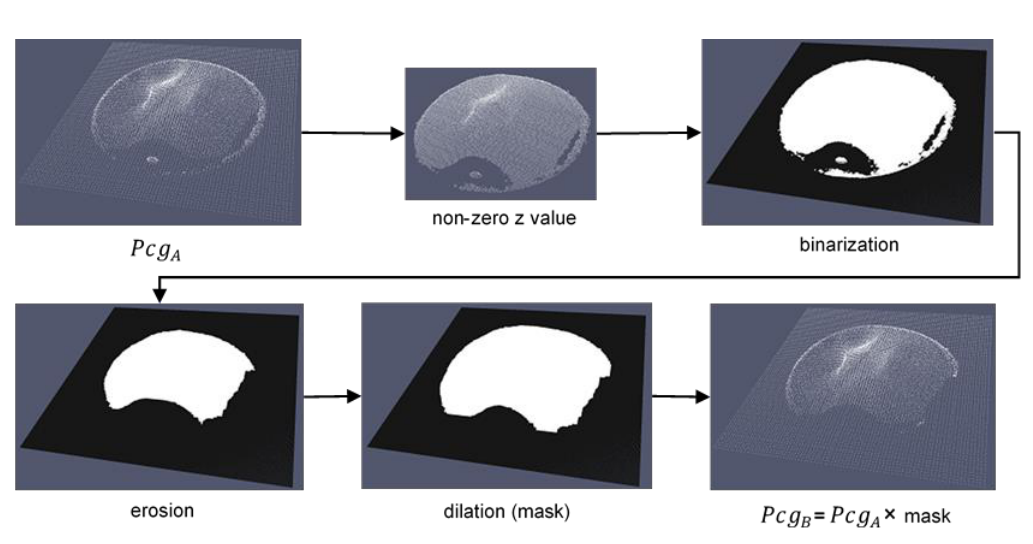
Figure A8. Illustration of the erosion-dilation procedure, which is applied to remove ring residuals. Illustration on Patient 004. Illustration on Patient